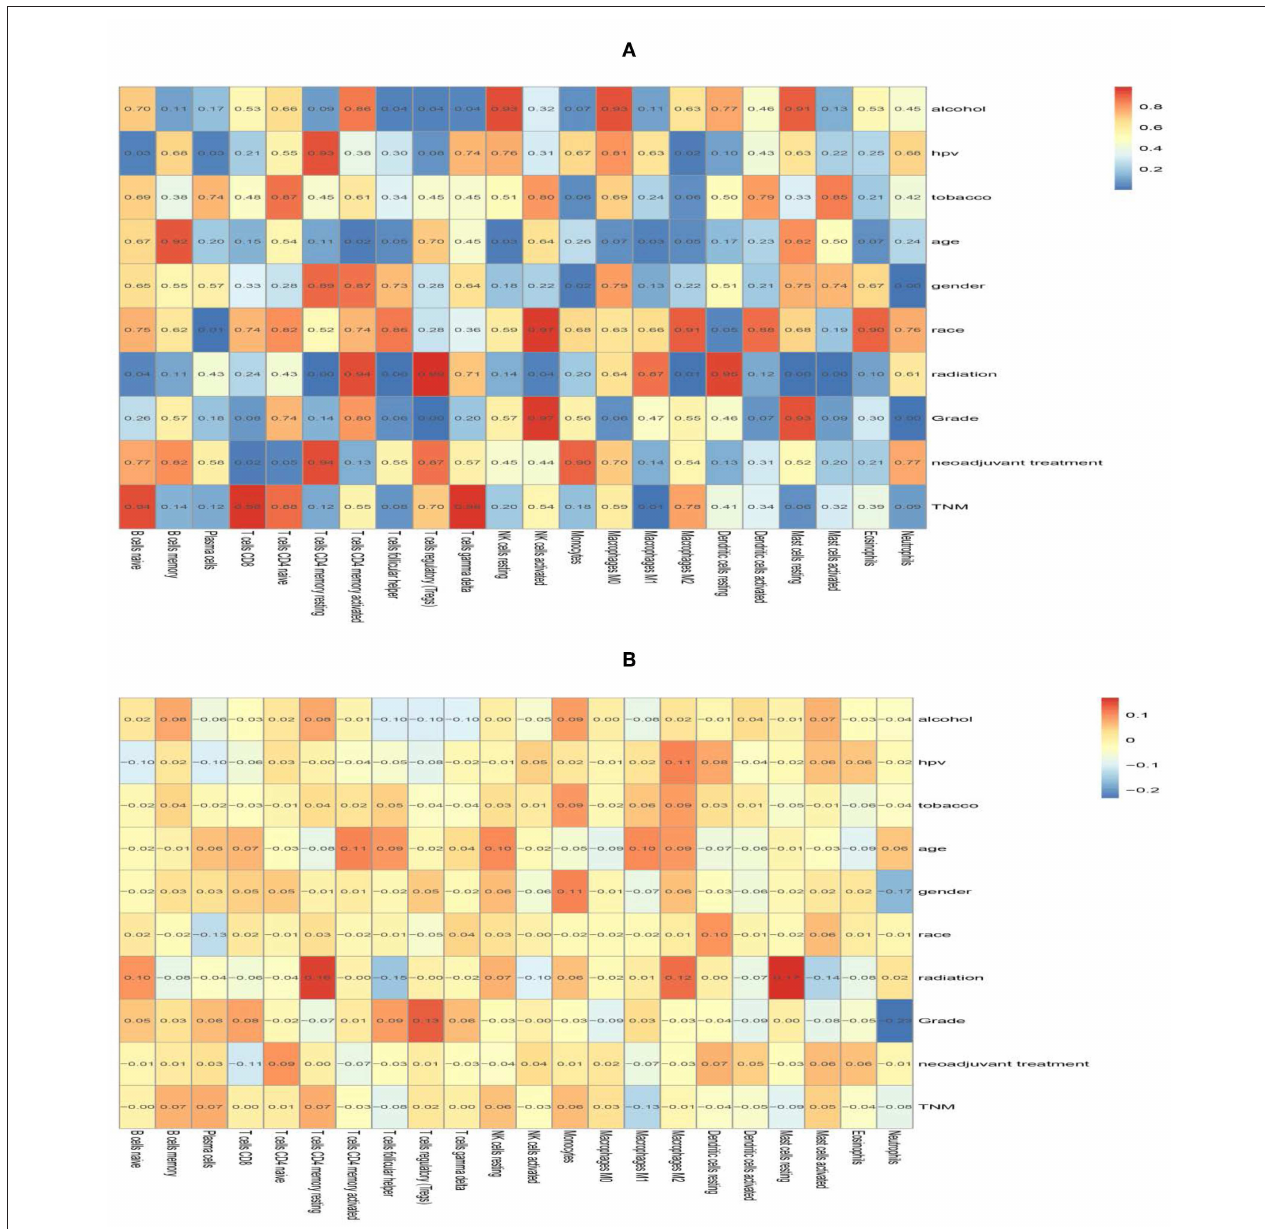
FIGURE 9 | The correlation heat map of 22 immune cells and clinical features. The value in the space shows the correlation coefficient (A) and the P value (B) .